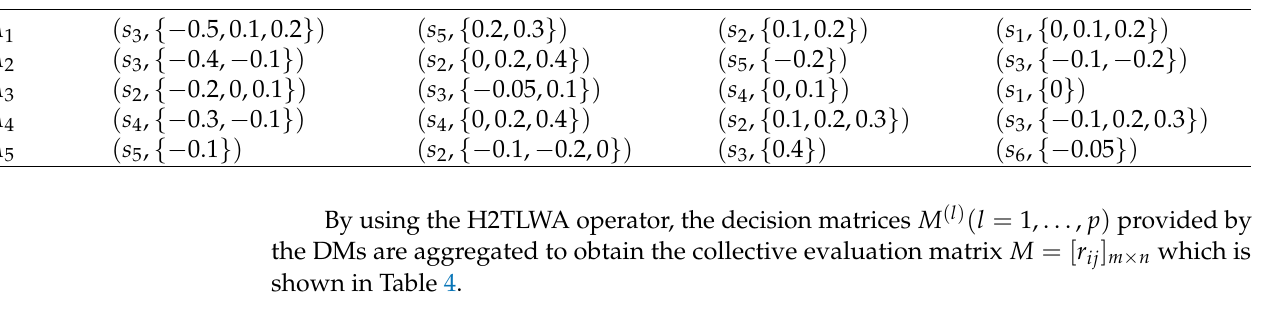
Table 4. The aggregated decision matrix M